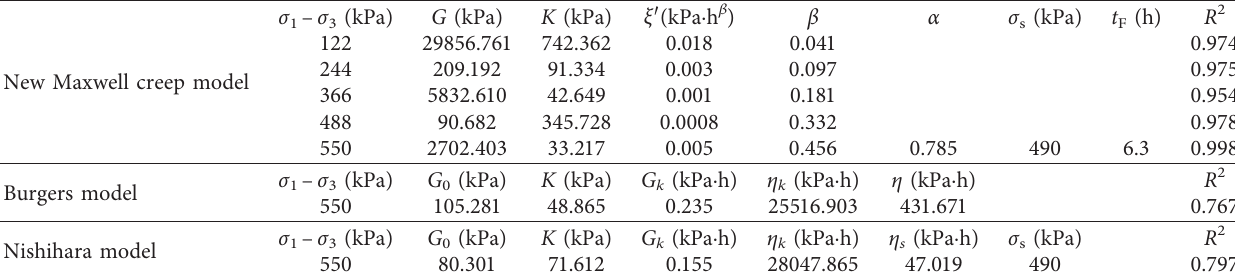
Figure 9: Axial strain versus time at different compactness levels: (a) k � 0.84; (b) k � 0.89; (c) k � 0.95; (d) k � 0.99. Table 2: Parameters determined through fitting the analysis based on creep test results of remolded